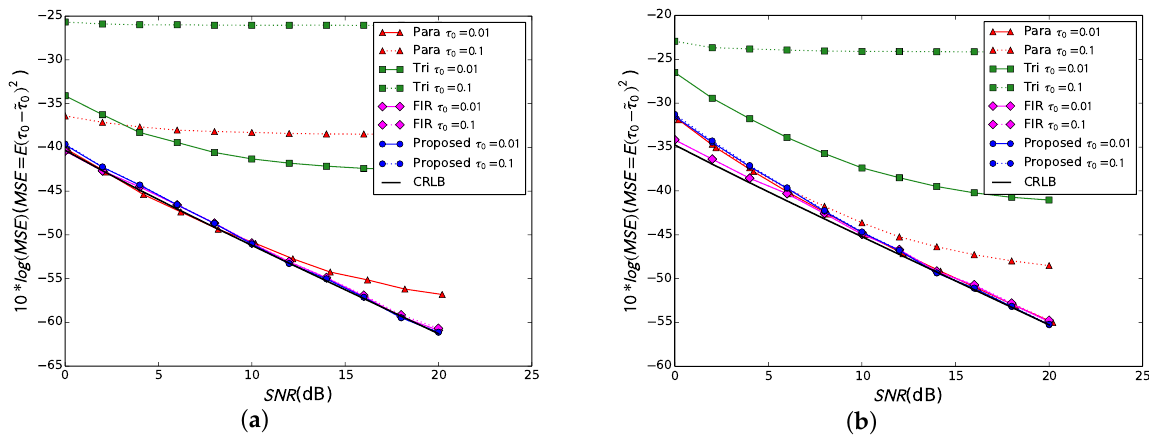
Figure 6. Comparison with existing approaches. ( a ) BT = 1/2, N = 16,384; ( b ) BT = 1/4, N = 16,384.